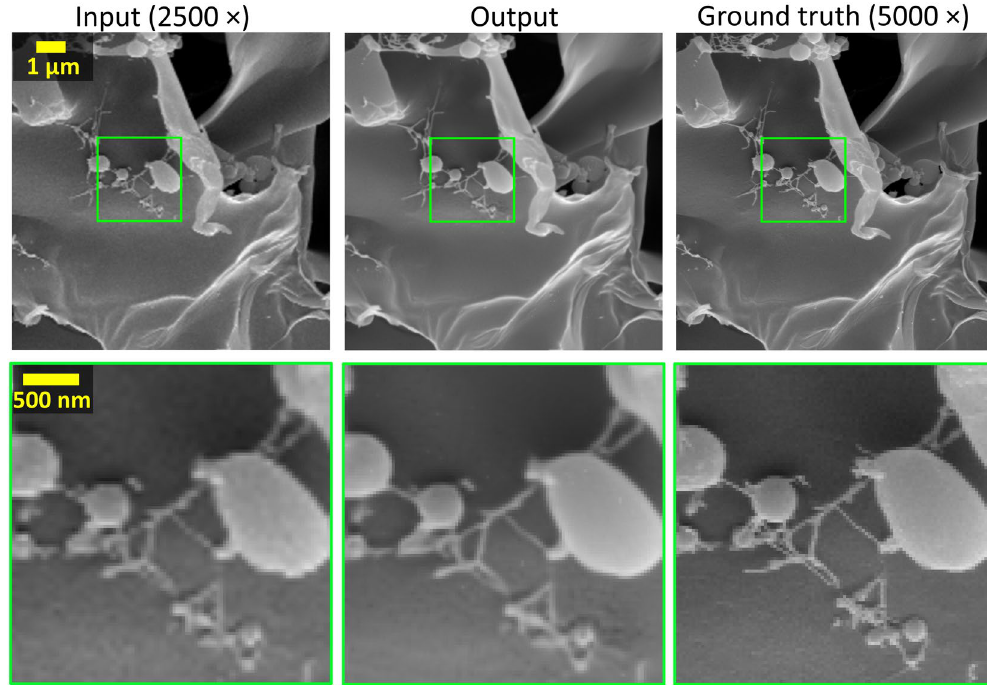
Figure 5. Examples of the up-sampled hydrogel network input images compared to the network output and the ground truth SEM images. Top: full field of view. Bottom: zoomed in region of interest. As the hydrogel sample is partially damaged during the imaging process, the ground truth images have a slightly different structure than the input images. This sample damage makes subpixel image co-registration impossible, which reduces the quality of the network training and limits the success of its inference, compared to earlier presented